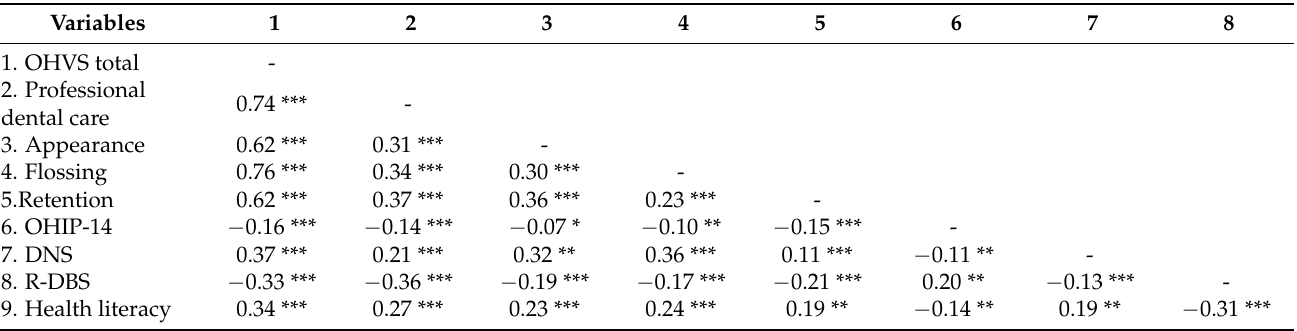
Table 4. Intercorrelations between the OHVS and other measures.